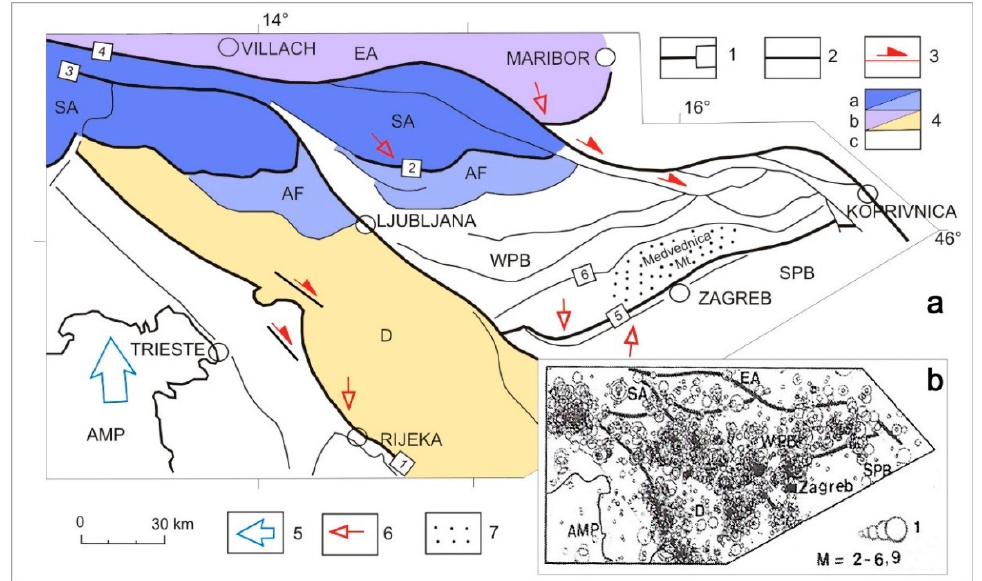
Figure 1. ( a ) Regional structural relations; Legend: 1—Most important faults: Gorica-Ilirska Bistrica-Rijeka fault (1), fault of the Southern Alps (2), Fella-Sava-Karlovac fault (3), Periadriatic-Drava fault (4), Zagreb fault (5), Brežice-Koprivnica fault (6); 2—Other important faults; 3—The direction of horizontal movement in fault zones; 4—Regional structural units: Southern Alps (SA) and Prealps (AF), Eastern Alps (EA), Dinarides (D), Adriatic Microplate (AMP), Western Pannonian Basin (WPB), Southern Pannonian Basin (SPB); 5—Direction of displacement of the Adriatic microplate; 6—Movement directions of structural units parts; 7—Medvednica. ( b ) Earthquake epicenters of magnitude 2–6.9 [4].